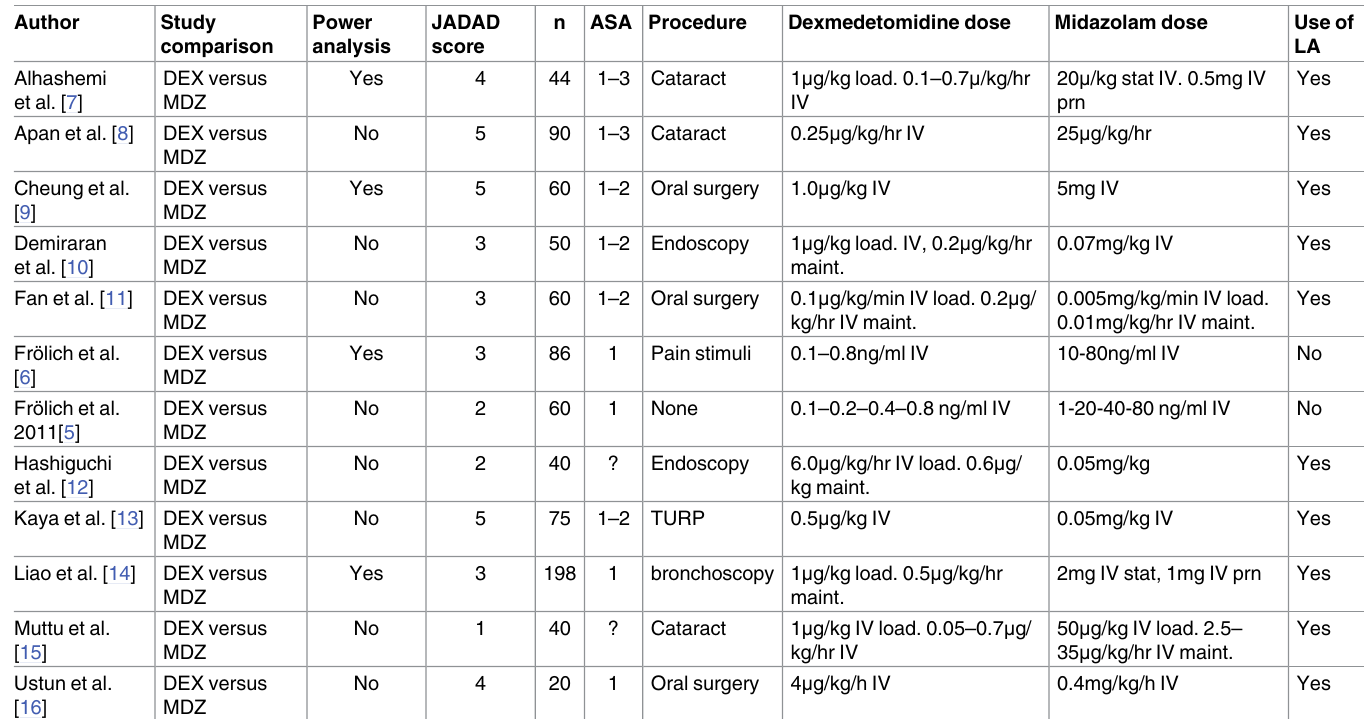
Table 1. Study design.